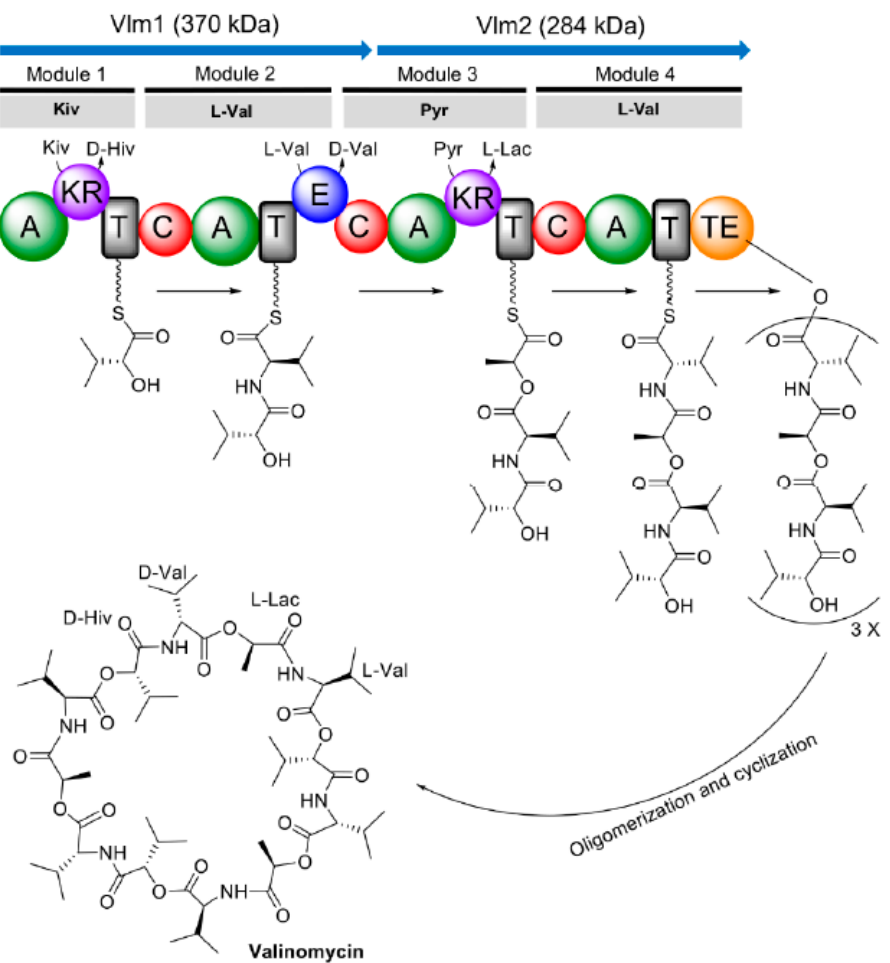
Figure 3. Proposed domain organization of valinomycin synthetase and valinomycin biosynthesis. Kiv, ketoisovalerate; D -Hiv, D -hydroxyisovalerate; L -Val, L -valine; D -Val, D -valine; Pyr, pyruvate; L -Lac, L -lactate; A, adenylation domain; KR, ketoreductase domain; T, thiolation domain; C, conden- sation domain; E, epimerase domain; TE, thioesterase